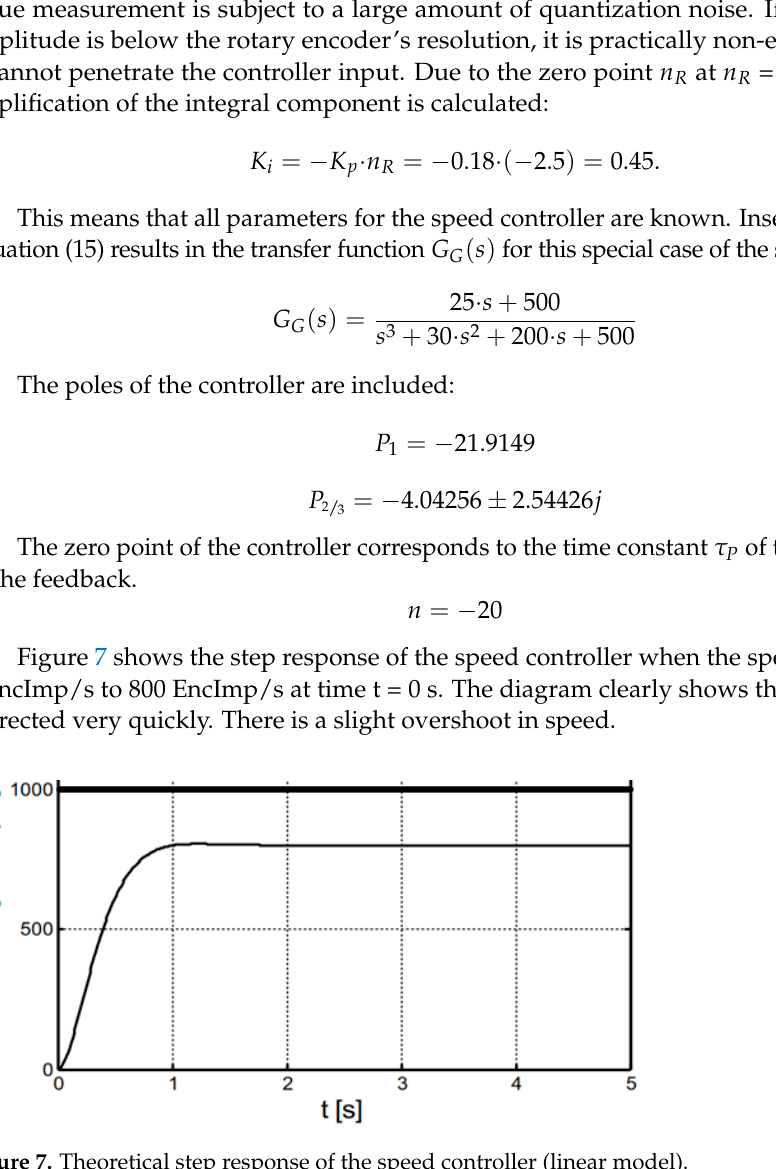
Figure 7. Theoretical step response of the speed controller (linear model).